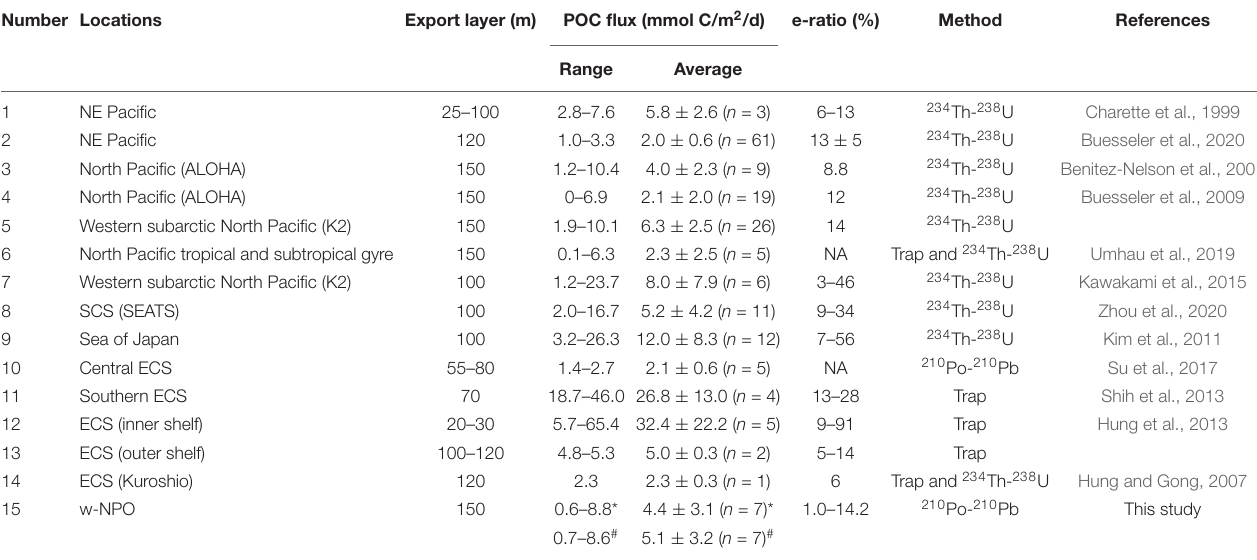
TABLE 4 | Comparison of the POC export fluxes estimated in different regions throughout the w-NPO and its surrounding marginal seas. Number